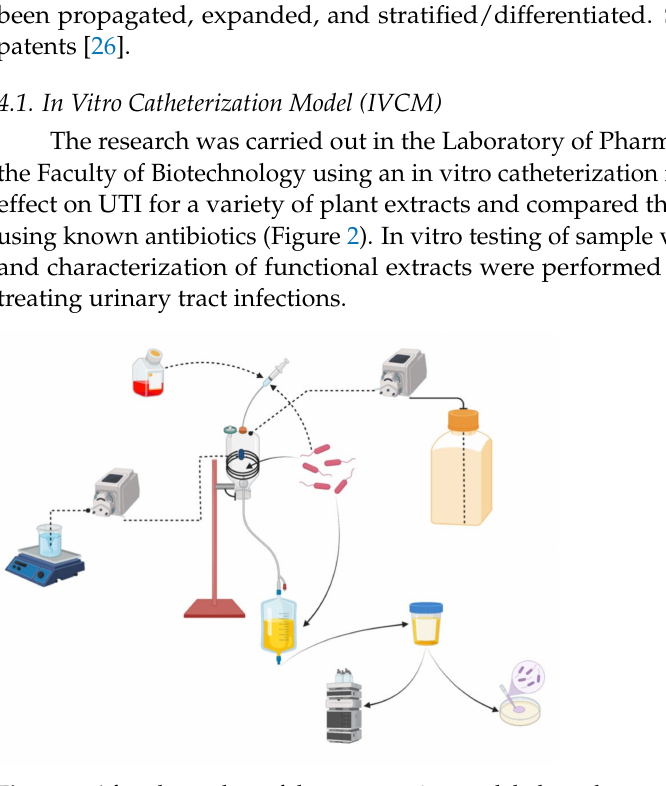
Figure 2. After the update of the constructive model, the redrawn schematic version of the in vitro catheterization model from the Faculty of Biotechnology, UASVM Bucharest. The figure contains the full details of the system, with a heating system made by the authors (left part of the picture). Samples are analyzed by microbiologic and chromatographic methods to fully understand the in vitro simulation [27]. The figure was created with the Biorender